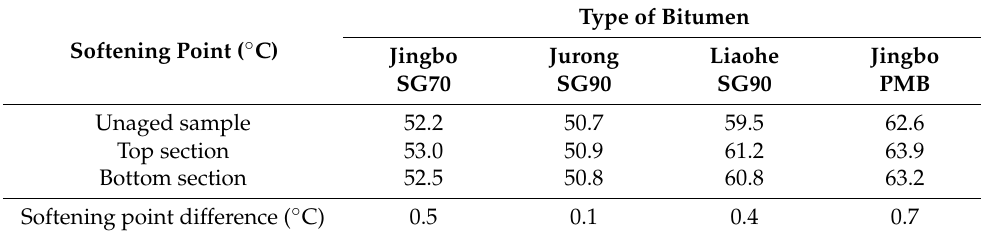
Table 3. Storage stability test results based on the difference in the softening